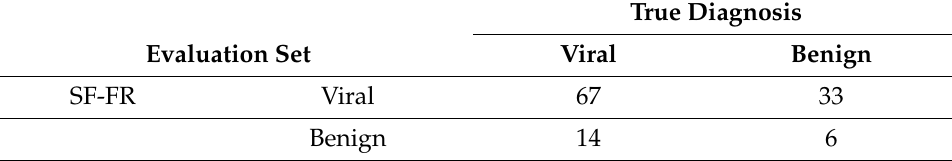
Table 10. C-SVM model: SF-BN. True Diagnosis Evaluation Set Viral Benign SF-BN Viral 15 5 Benign 0 20